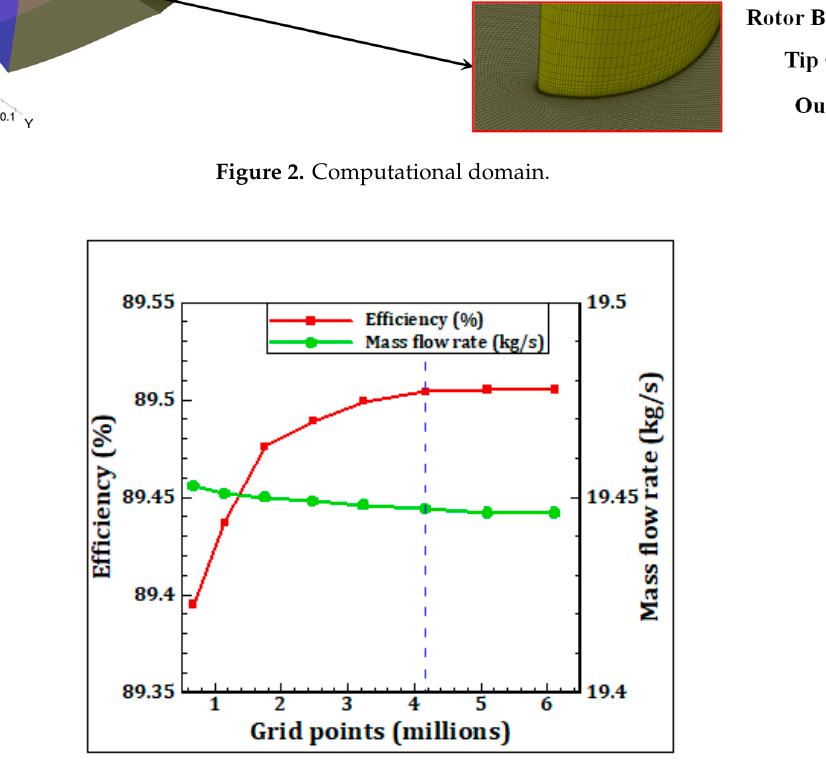
Figure 3. Grid dependency: Plot of mass flow and efficiency.